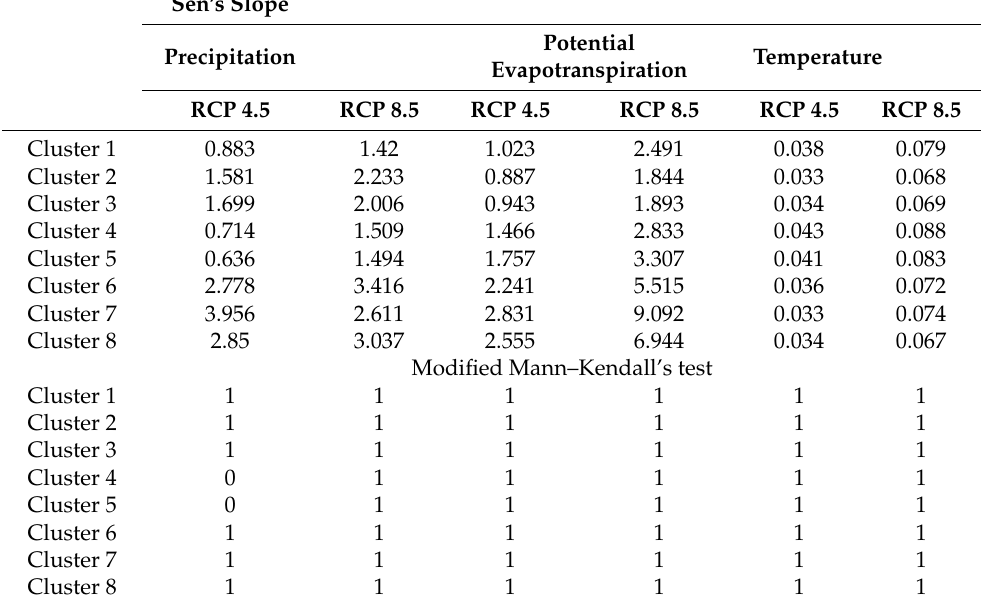
Table 2. Results of the modified Mann–Kendall and Sen’s slope test for the given precipitation, PET and temperature. Values of 1 and 0 represent a significantly increasing trend and no significant trend, respectively. The significance level is 0.05. Unit of values of Sen’s slope for precipitation, potential evaporation and temperature is mm/year, mm/year, ◦ C/year, respectively. Sen’s Slope Potential Temperature Precipitation Evapotranspiration RCP 4.5 RCP 8.5 RCP